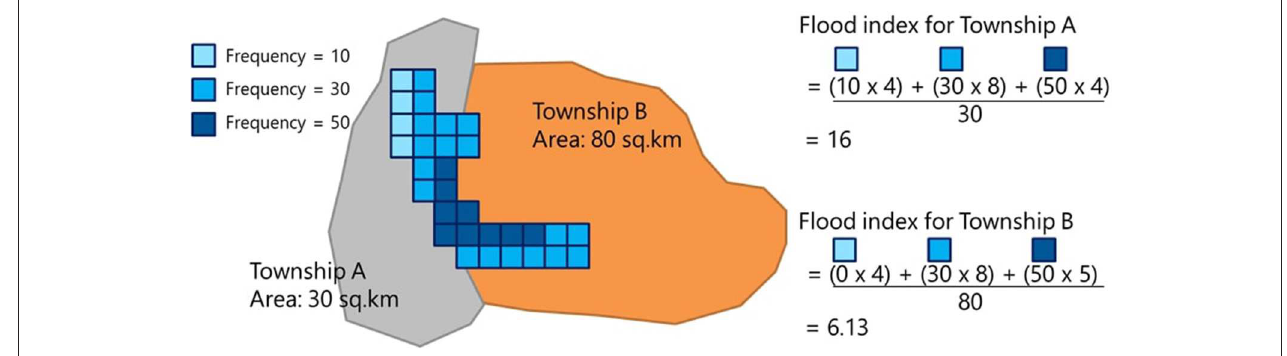
FIGURE 4 | Example of flood hazard index calculation for individual